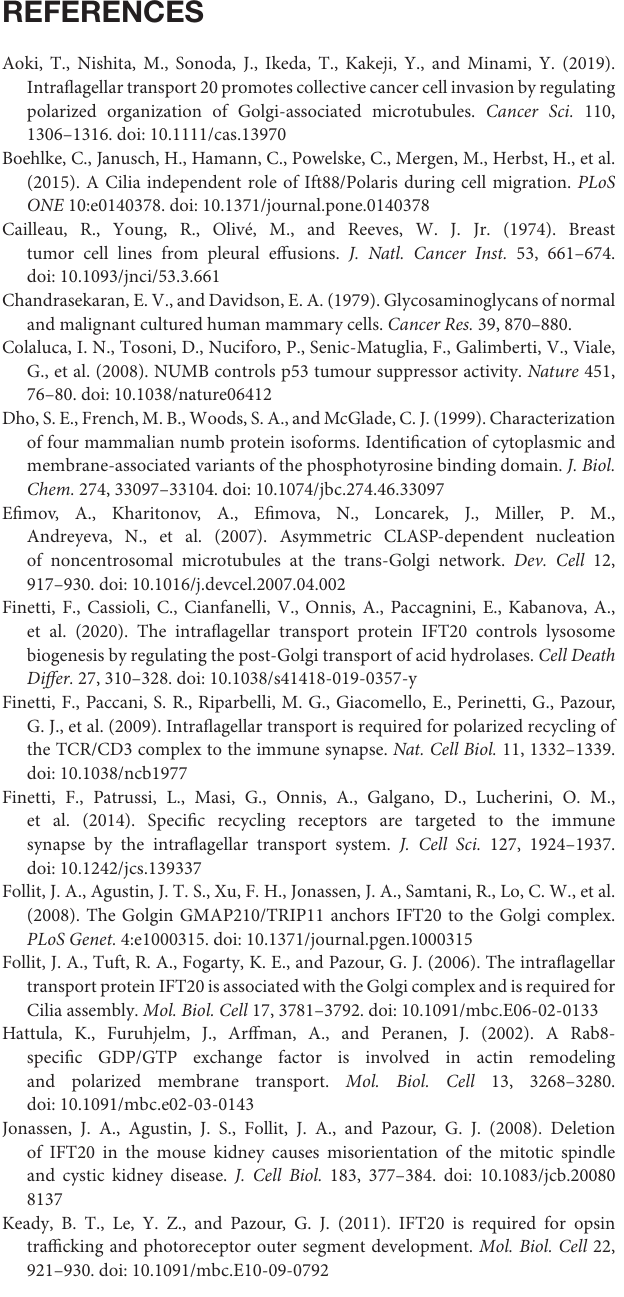
Supplementary Table 2 | Pearson’s R value between IFT20 and Rab fluorescent proteins.